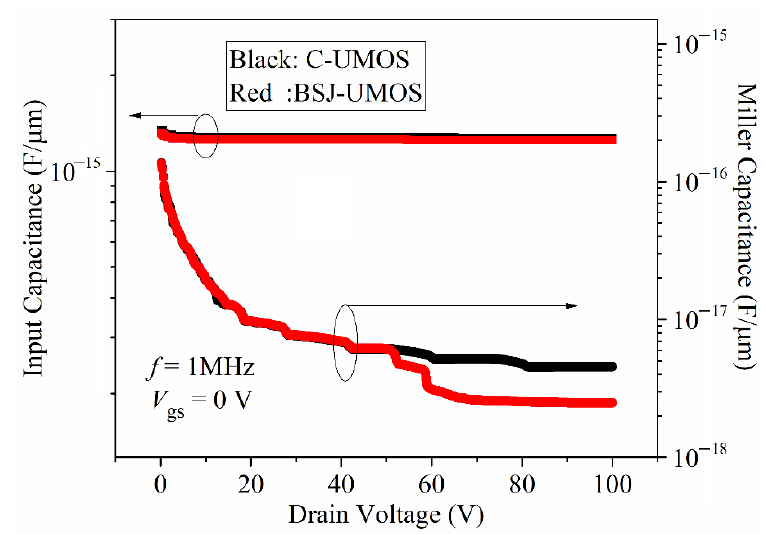
Figure 9. Comparisons of the parasitic capacitance in C-UMOS and BSJ-UMOS.